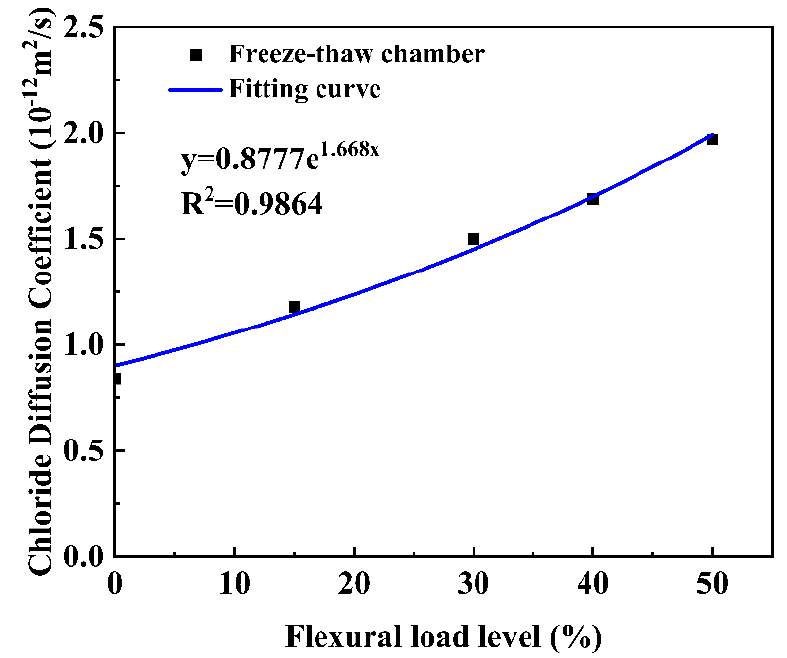
Figure 3. Coupling influence of flexural stress level and freeze–thaw on the chloride diffusion coefficient of concrete.